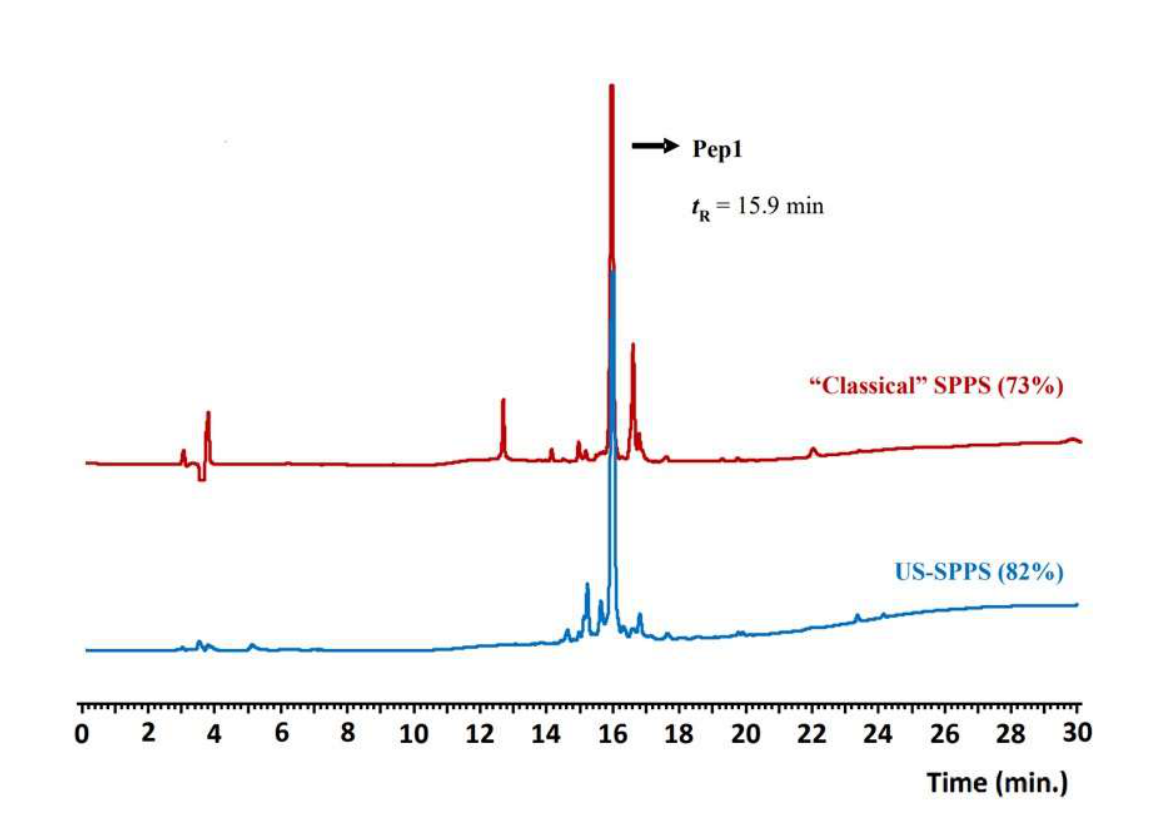
Figure 2. Analytical RP-HPLC chromatograms obtained for crude Pep1 ( t R = 15.9 min); comparison between the products obtained after synthesis by “classical” SPPS (red) or US-SPPS (blue). Gradient A (see experimental section). Table 2. Final yield (%) for crude Pep1 – Pep3 obtained by “classical” vs. US-SPPS.